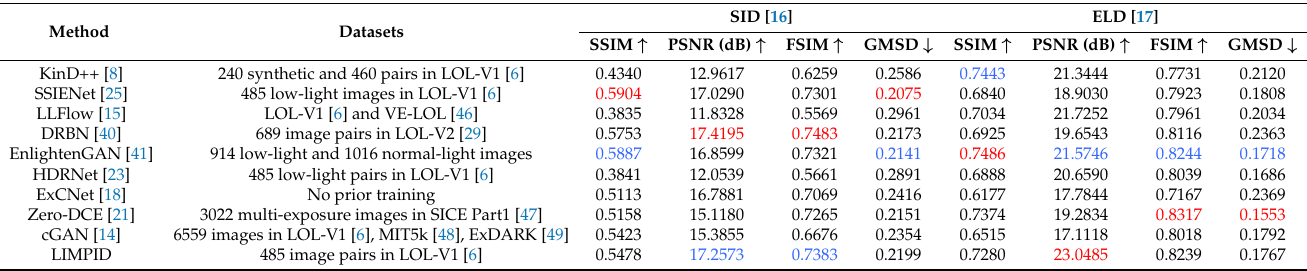
Table 1. The objective image quality evaluation metrics on the SID dataset [16] and ELD dataset [17]. ↑ denotes that higher metric values represent better image quality, while for ↓ the opposite is true. Red and blue denote the best and second-best results, respectively.